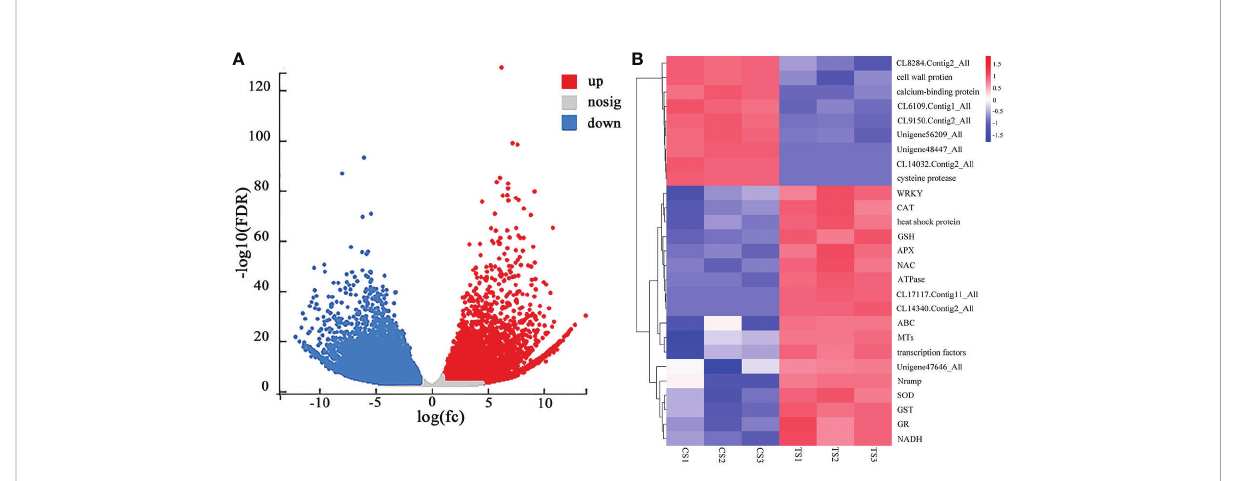
FIGURE 1 (A) CS-vs-TS difference volcano map of roots, and (B) heat map of the expression of some Pb-tolerant DEGs in roots of P. crinitum. (1000 mg·L -1 Pb stress treatment is indicated by TS and control experiment without Pb stress is indicated by